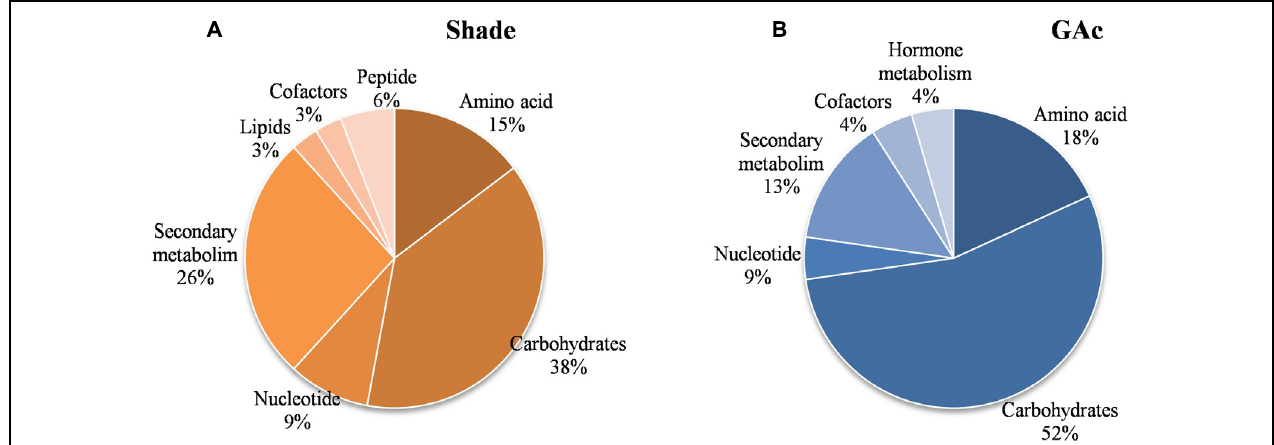
FIGURE 5 | Functional categorization of the 48 metabolites that showed significantly changes ( P < 0.05) in abundance. In shaded inflorescences (A) , 34 metabolites from carbohydrate, secondary metabolism, amino acid, nucleotide, peptide, cofactor, and lipid functional pathways were significantly